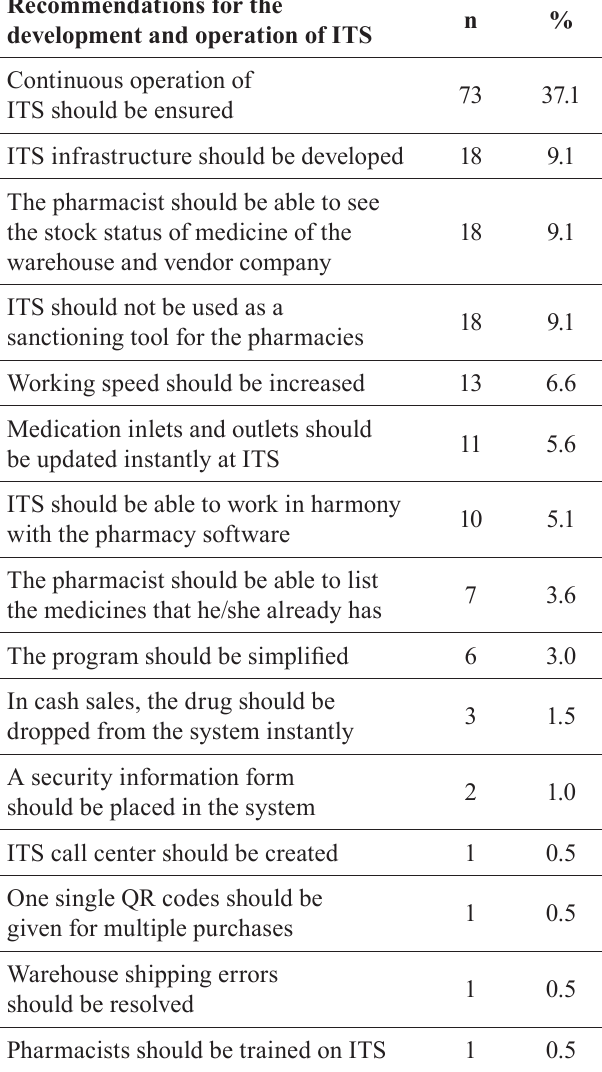
TABLE IV - Recommendations for the development